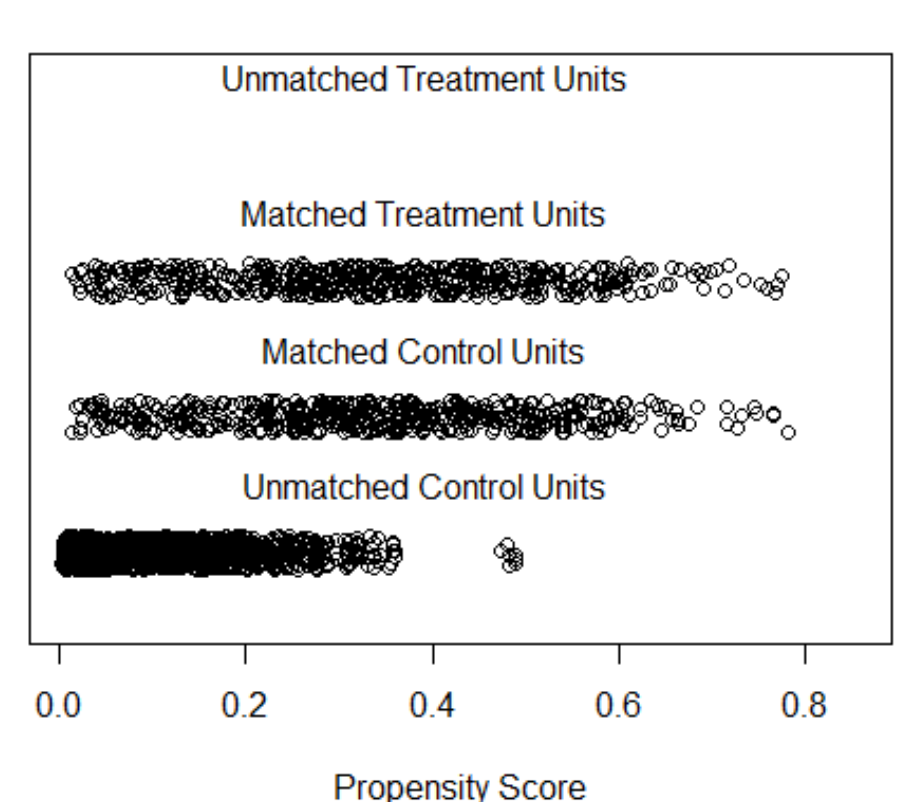
Figure 1. Distribution of propensity scores in the matching process.